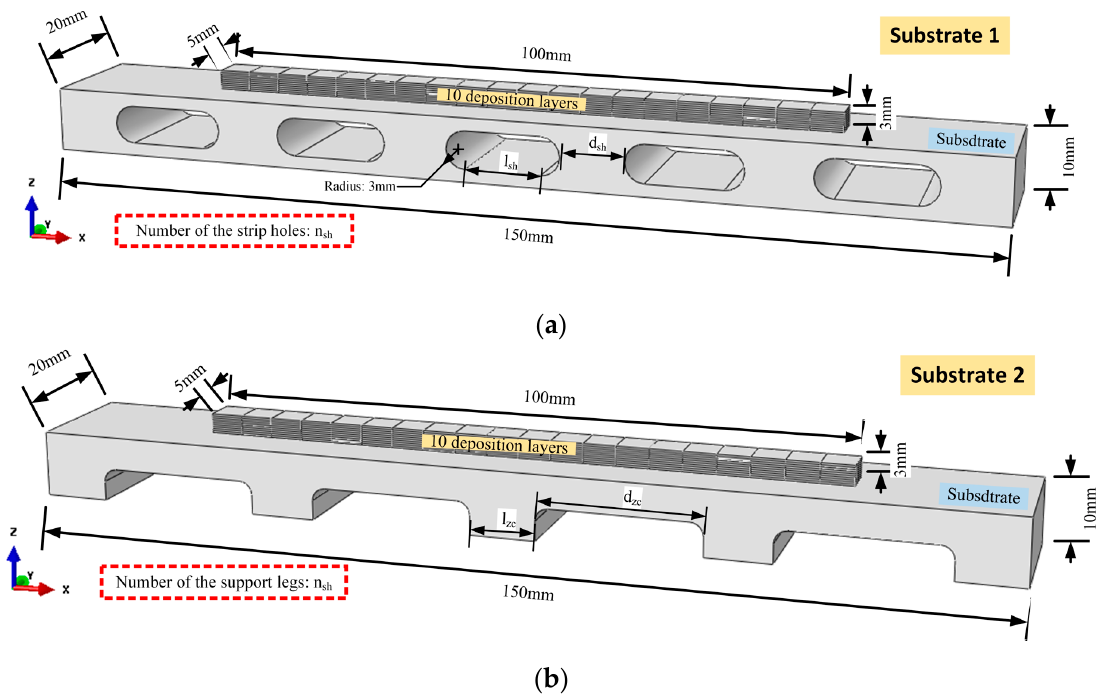
Figure 5. Different substrate structure designs used in DED AM: ( a ) substrate with long strip holes; ( b ) substrate with support legs.